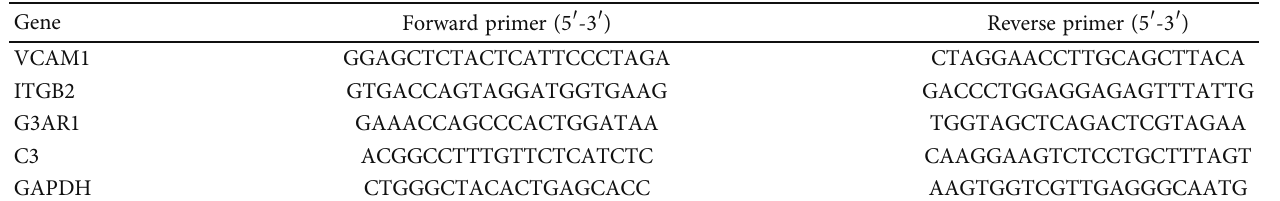
Table 1: Sequences of the primers used for quantitative real-time polymerase chain reaction.